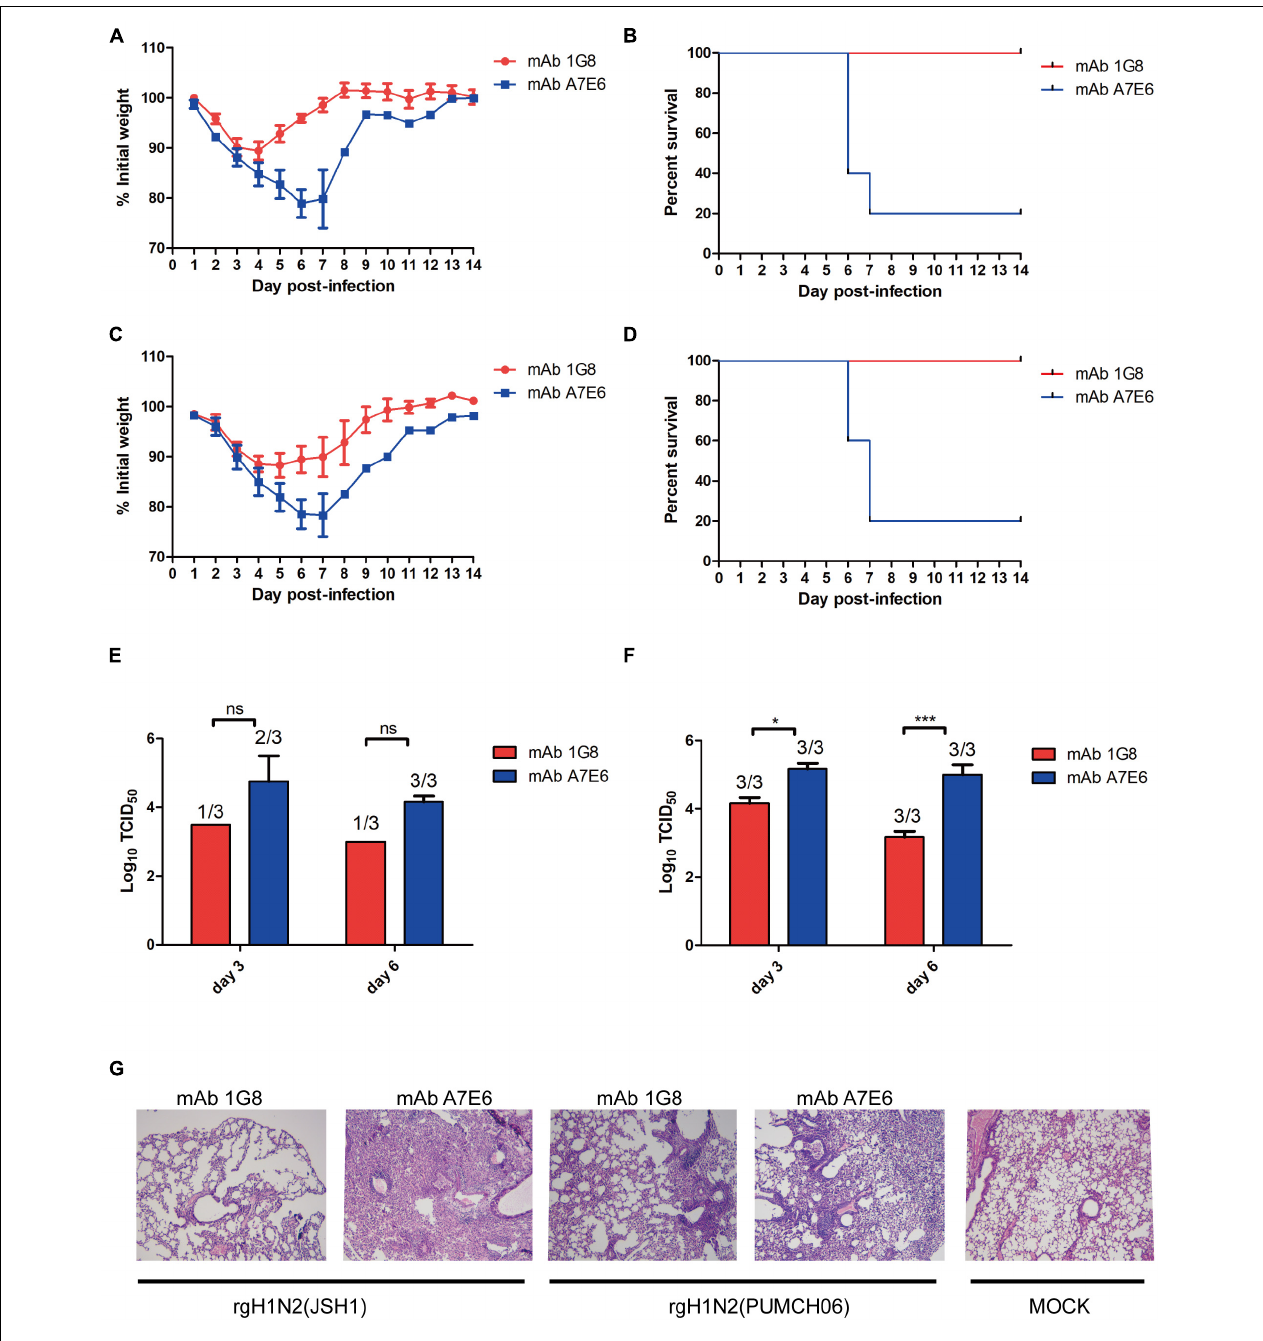
FIGURE 2 | In vivo protective effect of mAb 1G8 in prophylactic experiment. The mean percentage of the mice body weight (A) and the survival curves (B) of BALB/c mice ( n = 5 per group) treated with mAb 1G8 or mAb A7E6 after challenge with 10 7 TCID 50 rgH1N2(JSH1) viruses. The mean percentage of the mice body weight (C) and the survival curves (D) of BALB/c mice treated with mAb 1G8 or mAb A7E6 after challenge with 10 7 TCID 50 rgH1N2(PUMCH06) viruses. Viral titers in lungs of mice treated with mAb 1G8 or mAb A7E6 were determined on days 3 and 6 postinfection of 10 7 TCID 50 rgH1N2(JSH1) viruses (E) or rgH1N2(PUMCH06) viruses (F) . The p -values were calculated using two-way ANOVA using Dunnett’s multiple comparisons test with a 95% CI (ns, not significant; * p < 0.05; *** p < 0.0001). (G) Histological analysis of lungs from uninfected mice and infected mice treated with mAb 1G8 or mAb A7E6. The photos were taken in 100-fold magnification.